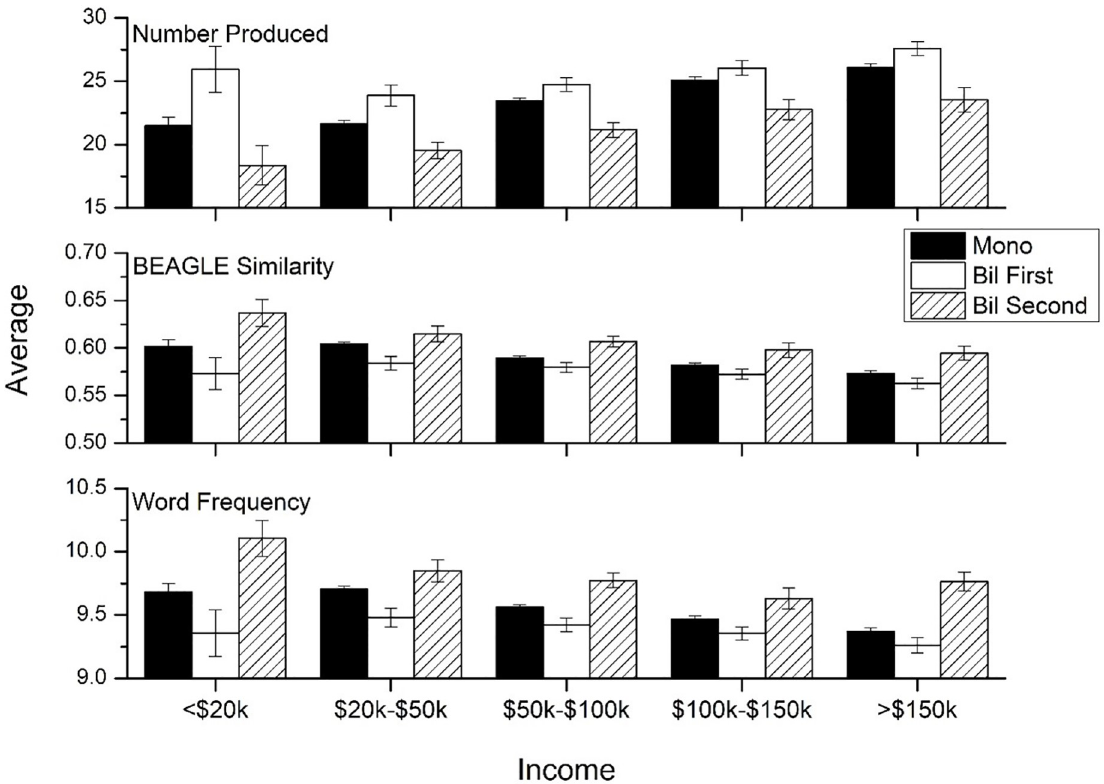
Fig 7. Means for the three psycholinguistic variables by language group and income level. Error bars represent 95% confidence intervals.